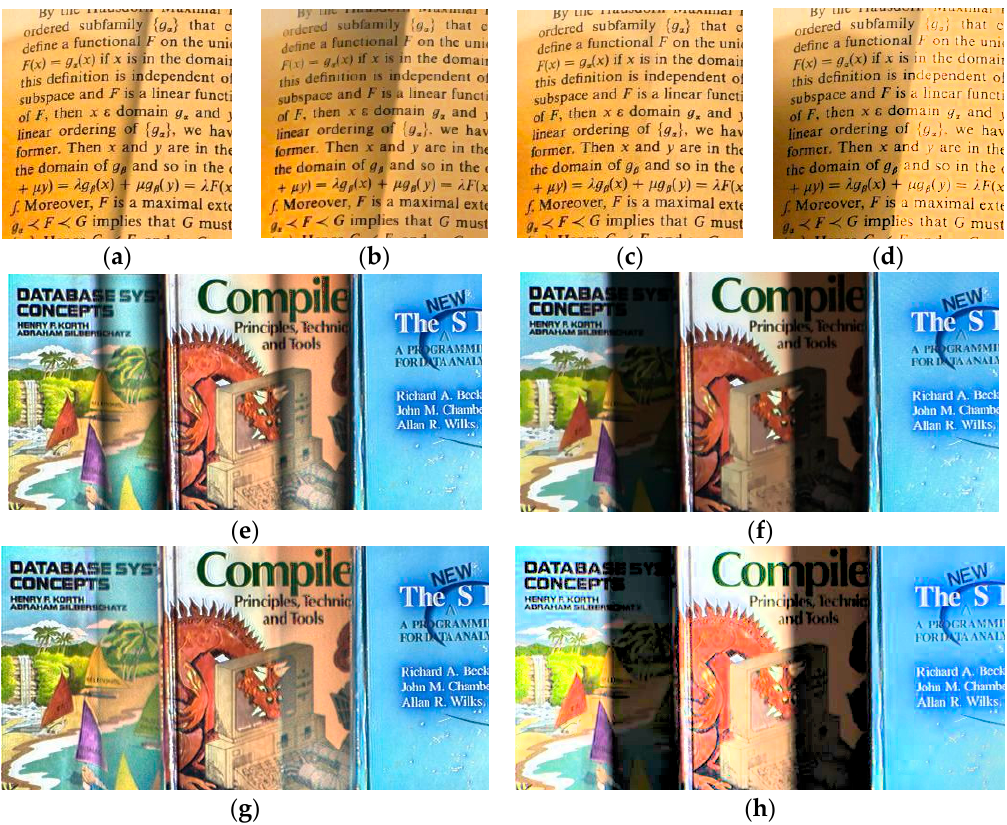
Figure 12. Reproduced degraded image (Figure 10b). ( a ) Ng’s model; ( b ) HoTVL1; ( c ) proposed model; ( d ) multiscale Retinex.